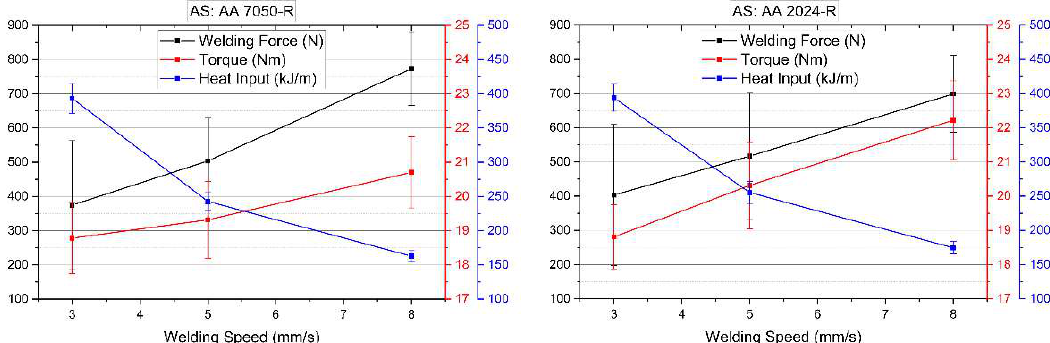
Figure 4. Measured forces and calculated energy input for different material positions.